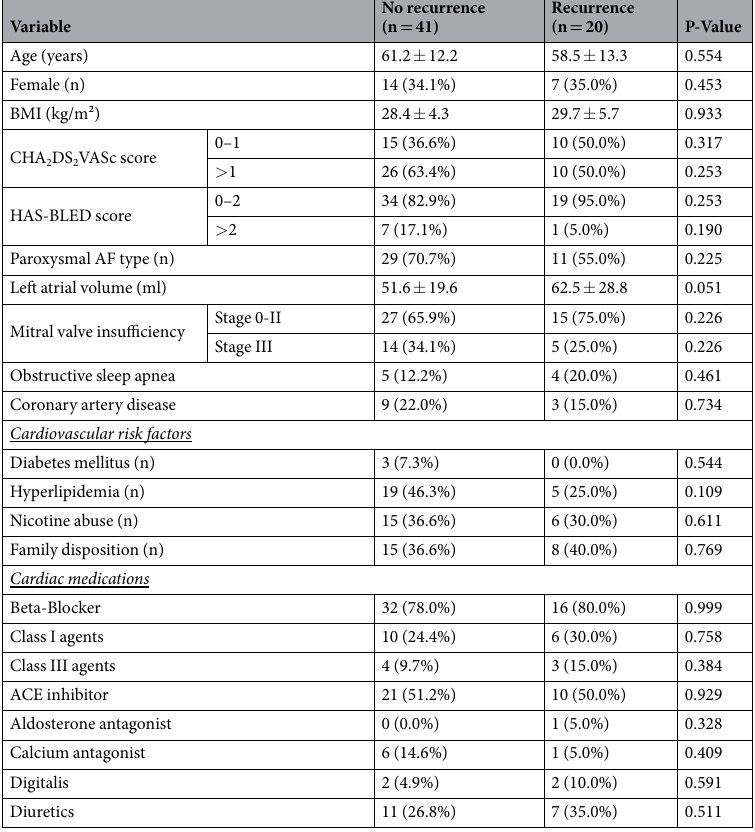
Table 1. Clinical characteristics in patients with and without recurrence of atrial fibrillation after ablation therapy. Data are mean ± standard deviation or absolute frequency with percentages in parentheses. BMI = body mass index; AF = atrial fibrillation; ACE = angiotensin converting